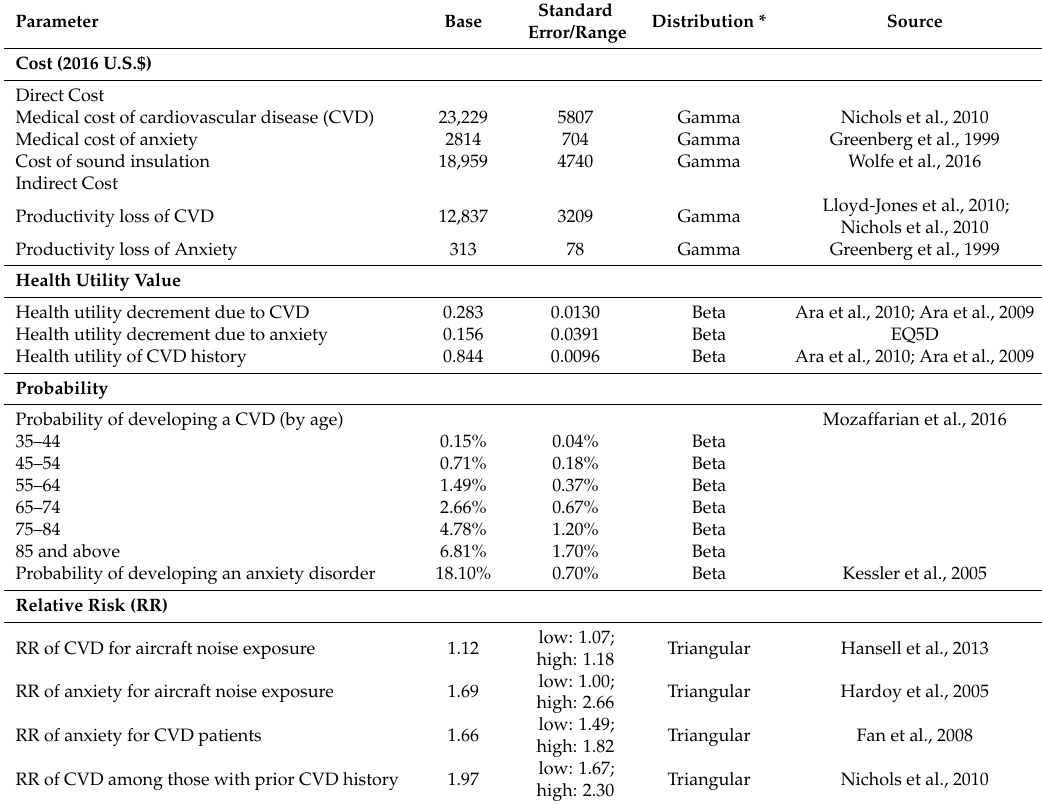
Standard Distribution * Source Error/Range